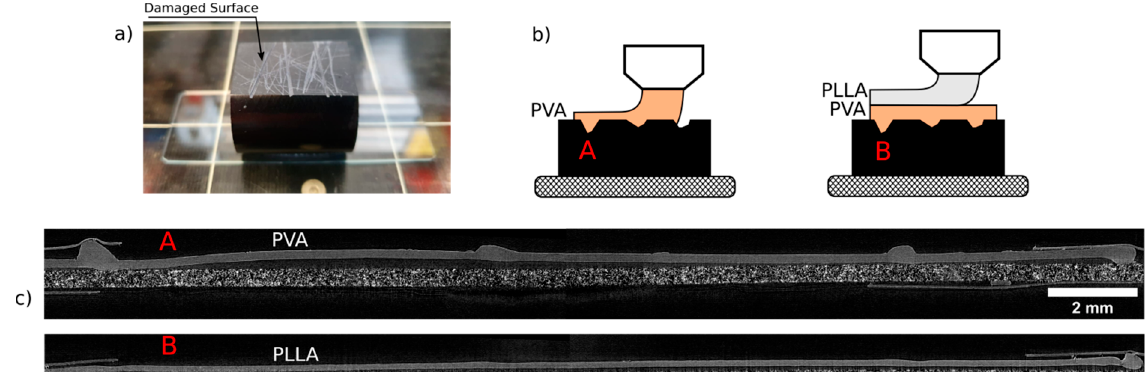
Figure 9. PVA layers are shown to be printed on ( a ) a damaged Bakelite surface such that ( b ) the surface is smoothed prior to the deposition of a PLLA layer; ( c ) µ-CT cross sections of PVA (A) and PLLA (B). An uneven thickness is observed in the PVA layer through contact with the damaged surface, whilst the PLLA layer remains uniform.